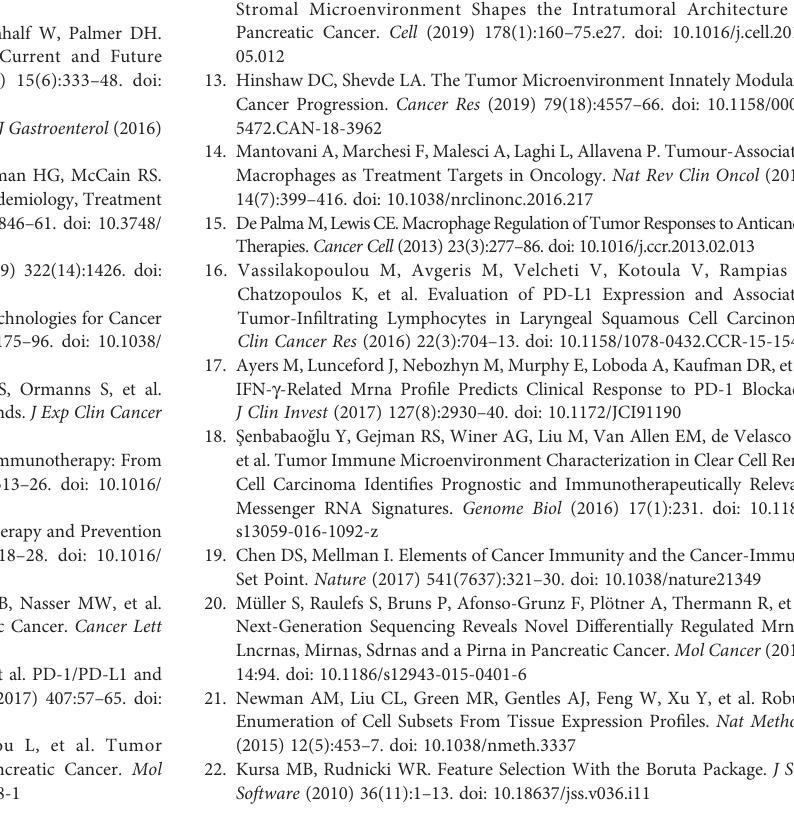
Supplementary Figure 1 | (A) Kaplan-Meier curves for the discrete ICI clusters of the TCGA and GEO cohorts, Log-rank test, P =0.995. (B) Kaplan-Meier curves for the discrete gene clusters of the TCGA and GEO cohorts, Log-rank test, P